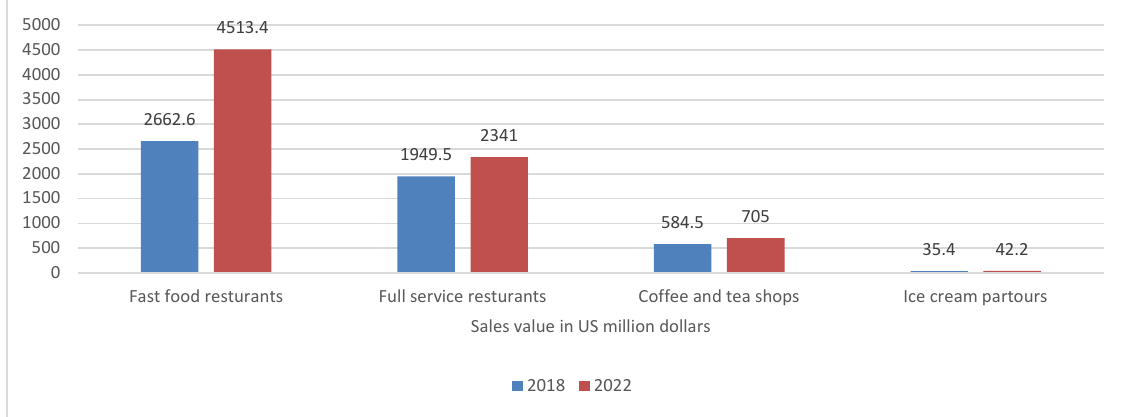
Fig. 2. sales value of food industry in